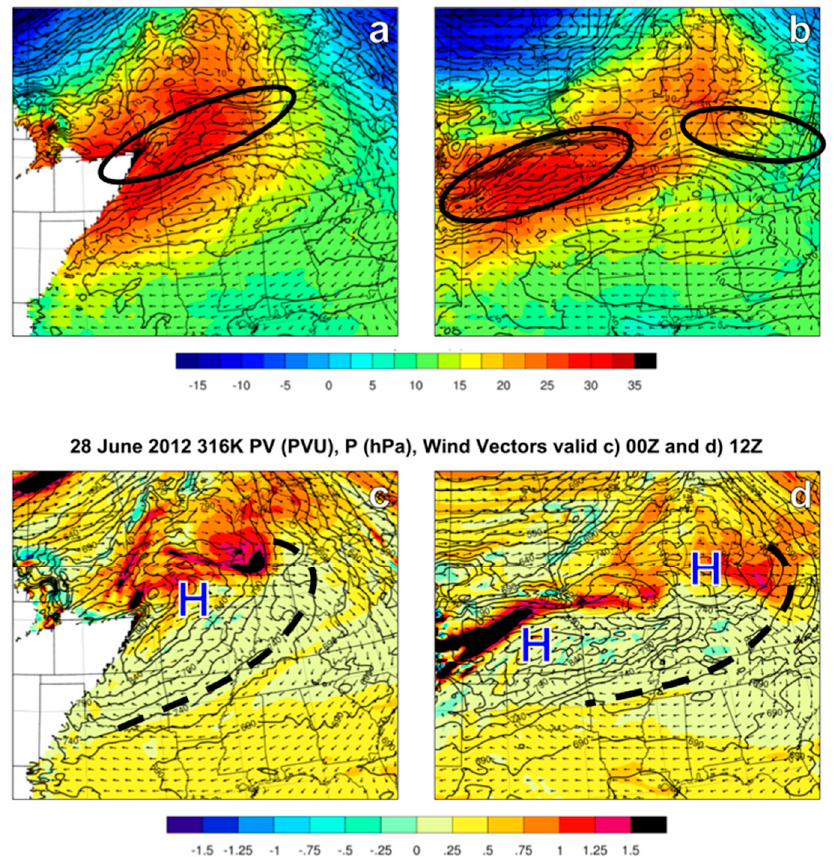
Figure 17. WRF-ARW 18 km simulated 316 K temperatures (°C, color fill), wind isotachs (black lines in m/s), and wind vectors for ( a ) 00Z and ( b ) 12Z 28 June, as well as simulated 316 K potential vorticity (PVU, color fill), pressure (black lines in hPa), and wind vectors valid at ( c ) 00Z and ( d ) 12Z 29 June. The white-filled areas in panels ( a , c ) represent locations where the isentropic surface is interrupted by higher terrain. Black ovals indicate the location(s) of mid-level jetlets (MLJ). Black dashed lines indicate surges of the EML eastwards, and blue “H”s represent meso-highs being ejected from the main EML.